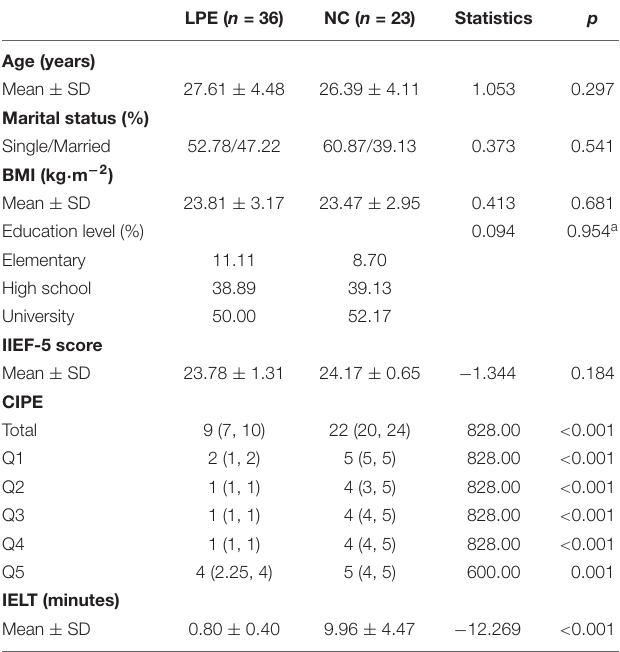
TABLE 1 | Demographic and clinical data of LPE patients and